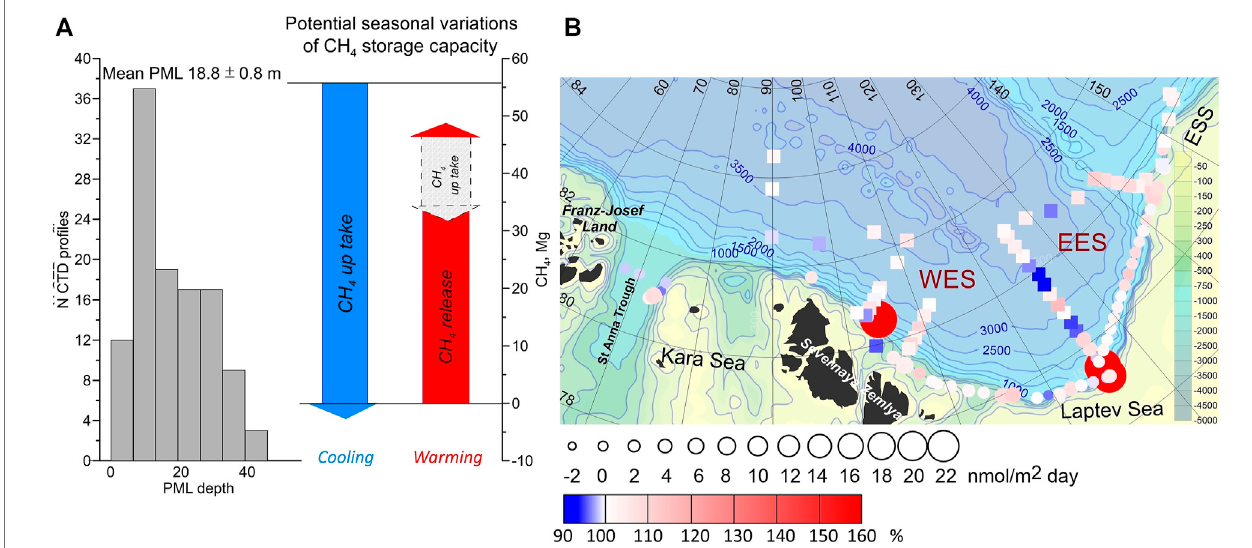
FIGURE 3 | Mean PML depths and the potential CH 4 storage capacity (A) ; CH 4 fl ux and saturation related to the atmosphere (B) . (A) The blue arrow shows the potentialCH 4 up-takecausedbycooling.Coolingtakesplacewhenthewatermassentersthepolarregionandinautumnduringthefreezeup.Theredarrowshowsthe potentialreleaseofCH 4 causedbywarming,e.g.asconsequencesofseaiceretreat.Fresheningpartlycounterbalancesthereleasecapacity.Thediscrepancybetween both arrows are caused by variations in the SC calculated with different temperatures in WES and ESS ( Figure 2 ). (B) SO 4 saturation related to the atmospheric equilibrium is shown by colors. Squares and circles show ice-covered and ice-free stations, respectively. The size of circles is related to potential sea-air SO 4 fl uxes in open water